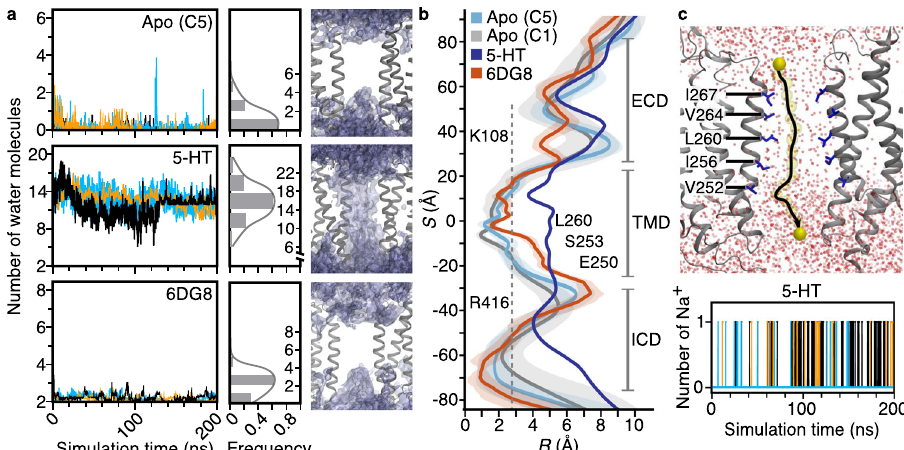
Fig. 4 Pore permeability. a Averaged water molecule density within 4 Å of L260 at the TMD. Left panel — number of water molecules, solid lines in different colours indicate results of three simulations and the histograms show the averaged distribution of the number of observed water molecules. Right panel — water molecule densities are shown in purple, two subunits of each model shown in grey. b Pore radius ( R ) pro fi le relative to the distance along the receptor pore axis ( S ) derived from the MD simulations; solid lines represent the average radii over the last 50 ns of the simulations and shading the corresponding standard deviation. The dashed grey line represents the radius of a hydrated sodium ion (2.76 Å). c Top panel — the trajectory (black line) of a single sodium ion (yellow) translocated across the pore (Supplementary Movie 2). Bottom panel — the number of sodium ions translocated throughout three 200-ns